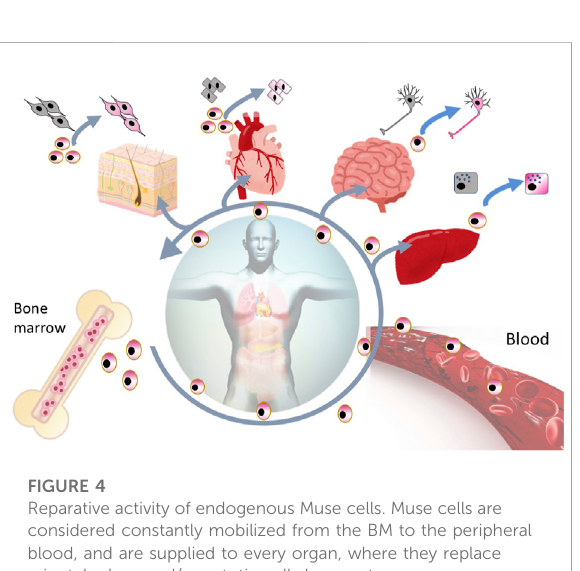
Reparative activity of endogenous Muse cells. Muse cells are considered constantly mobilized from the BM to the peripheral blood, and are supplied to every organ, where they replace minutely damaged/apoptotic cells by spontaneous differentiation into the damaged/apoptotic cell